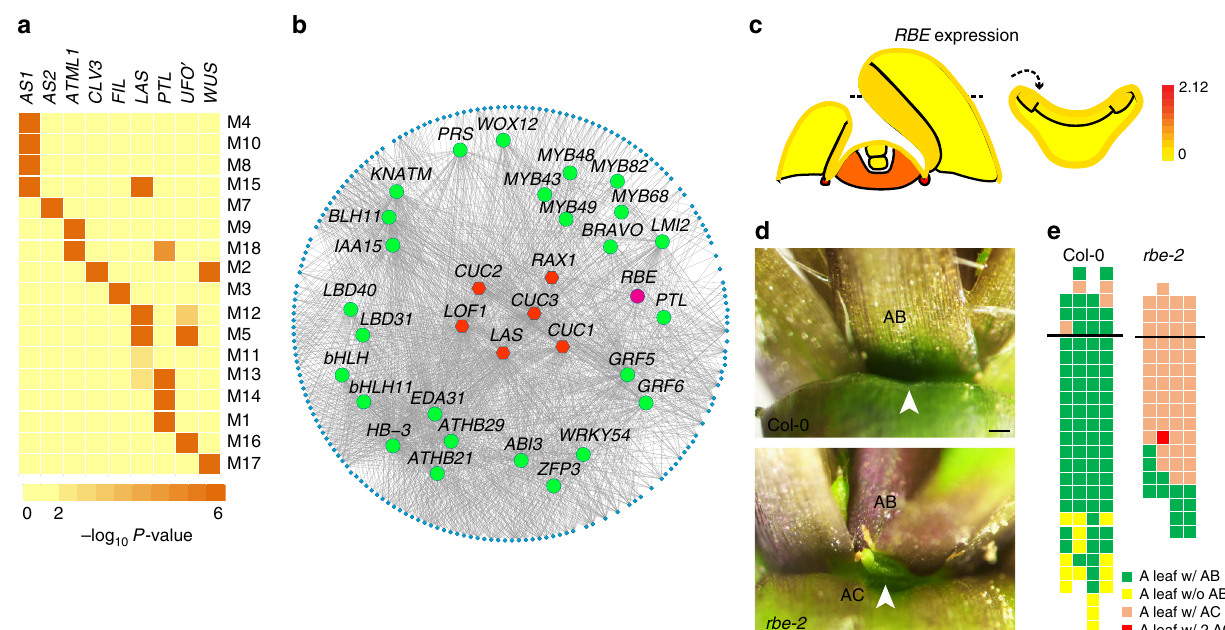
Fig. 4 Boundary-speci fi c module and function of RBE in AM initiation. a Relationships of the domain-enriched genes with GCN modules. Colors indicate the enrichment assessed by hypergeometric tests of overlapping gene numbers. Labels on the top show domain and corresponding modules displayed in the right panel. b Module M12 displayed by Cytoscape showed a signi fi cant enrichment of known boundary-speci fi c genes involved in AM initiation. Transcription factors are in the middle, in which red color indicates known AM regulators, while green represents others. RBE is represented in purple. Dots around the circle represent other co-expressed genes. Lines represent relationships. c Expression pattern of RBE viewed by the eFP browser. d Increased AM initiation in rbe-2 mutant. Rosette leaf axil from Col-0 with a single axillary branch (AB), and from rbe-2 mutant with an accessory bud (AC, arrowhead). Scale bar = 200 μ m. e Schematic representation of axillary bud formation in leaf axils of wide-type and mutant plants. Each column represents a single plant, and each square within a column represents an individual leaf axil. The horizontal line indicates a border between cauline leaf and rosette leaf, with the youngest to oldest from top to bottom. Green or yellow colors indicate the presence or absence of an axillary bud in the particular leaf axil. Orange or red color indicates the presence of one or two accessory buds,